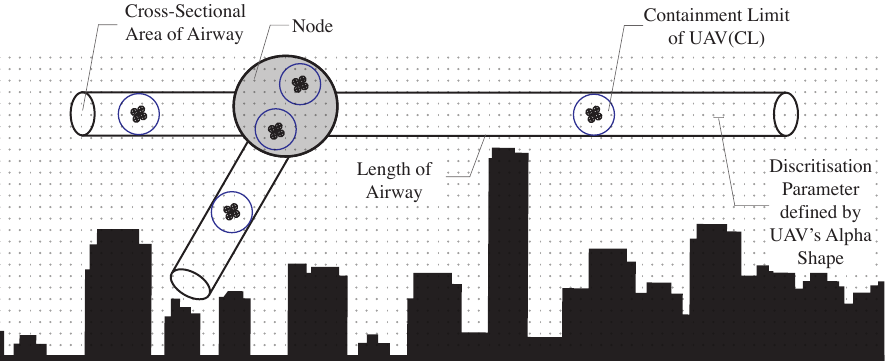
Figure 5. Airways and Nodes in proposed UTM model